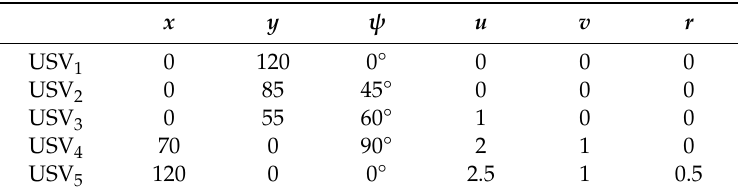
Table 2. Initial parameters of USVs.